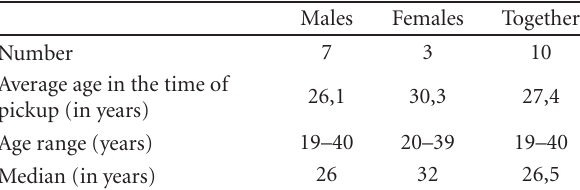
Table 2: Control group of healthy (non-dilated)